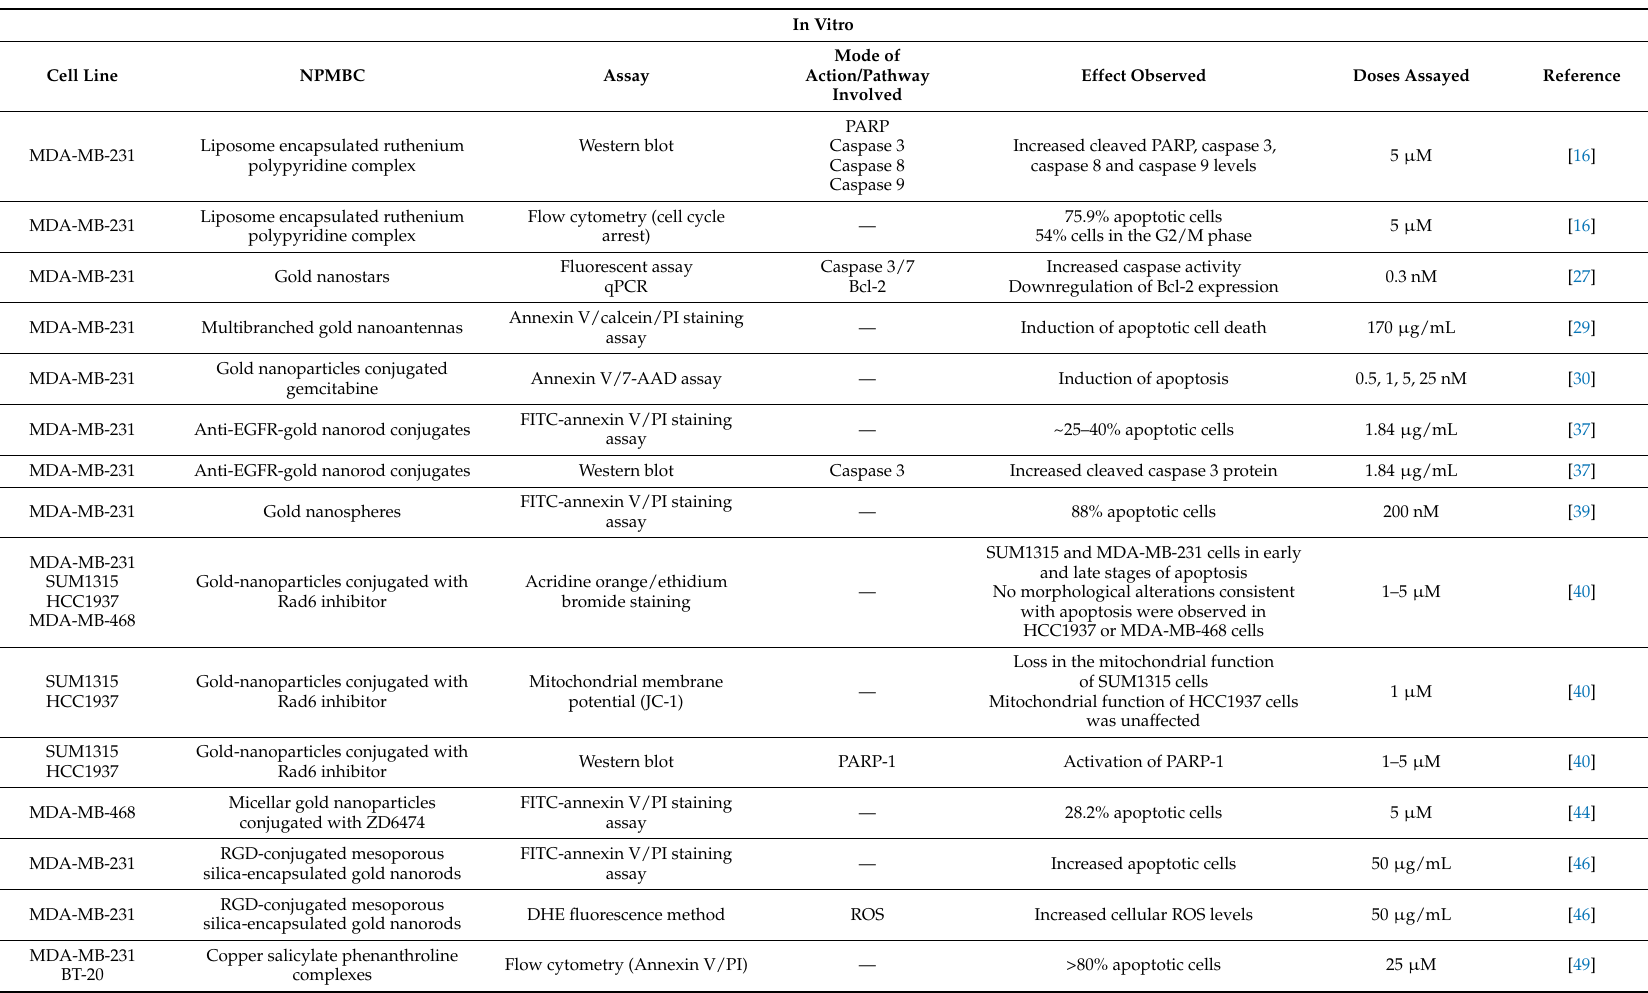
Table 3. Non-platinum metal based complexes (NPMBC) inhibit the in vitro and in vivo growth of triple-negative breast cancer (TNBC) cells by inducing